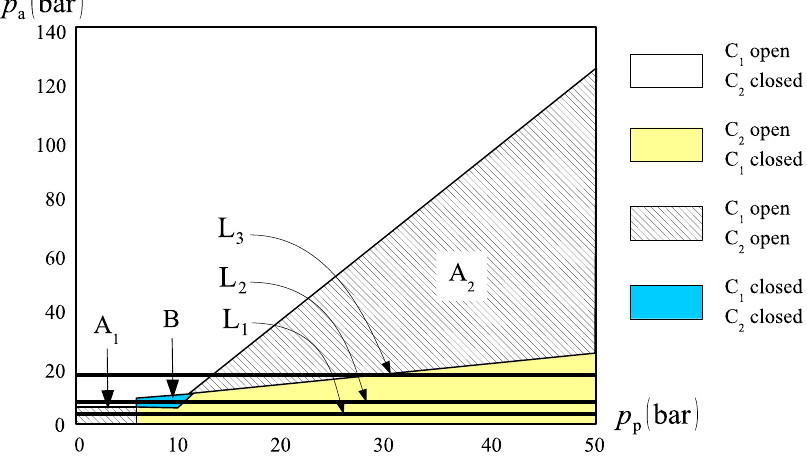
Figure 16. Check valves status at first and fourth quadrant operation.